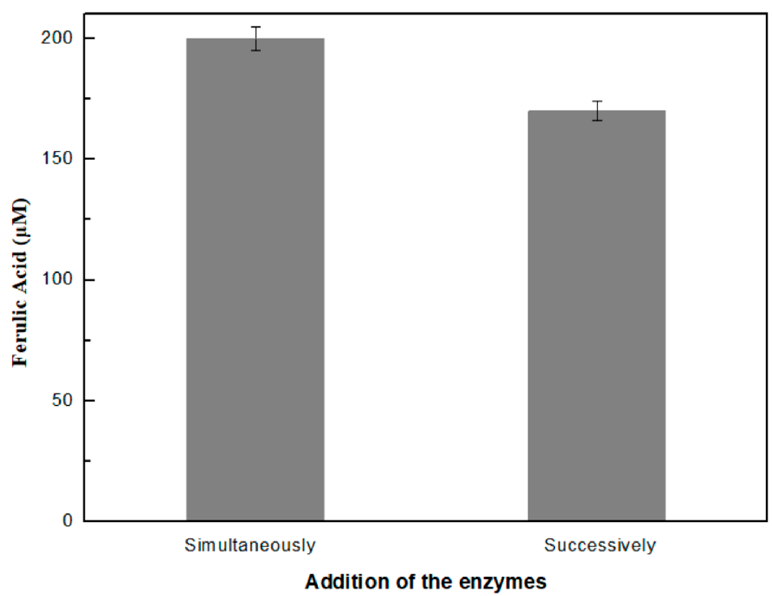
Figure 2. Effect of the simultaneous and successive addition of xylanase and esterase on the amount of ferulic acid produced.